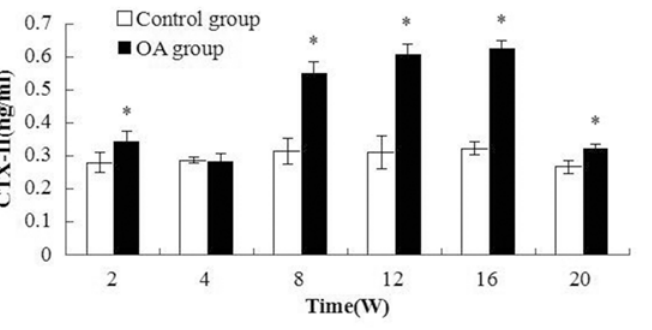
Fig 3. Plot of CTX-II level changes in the serum. The CTX-II levels for the OA groups were higher than that for the control group, except at time point W4. The CTX-II level peaked at W16. Significant differences were found between the control group and all the OA groups except the group evaluated 4 weeks post-surgery. Asterisks indicate significant differences with paired-samples T